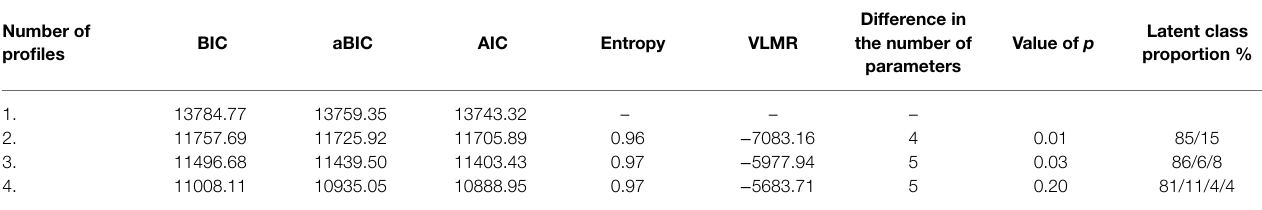
TABLE 2 | Fit indices for the compared latent profiles. Number of